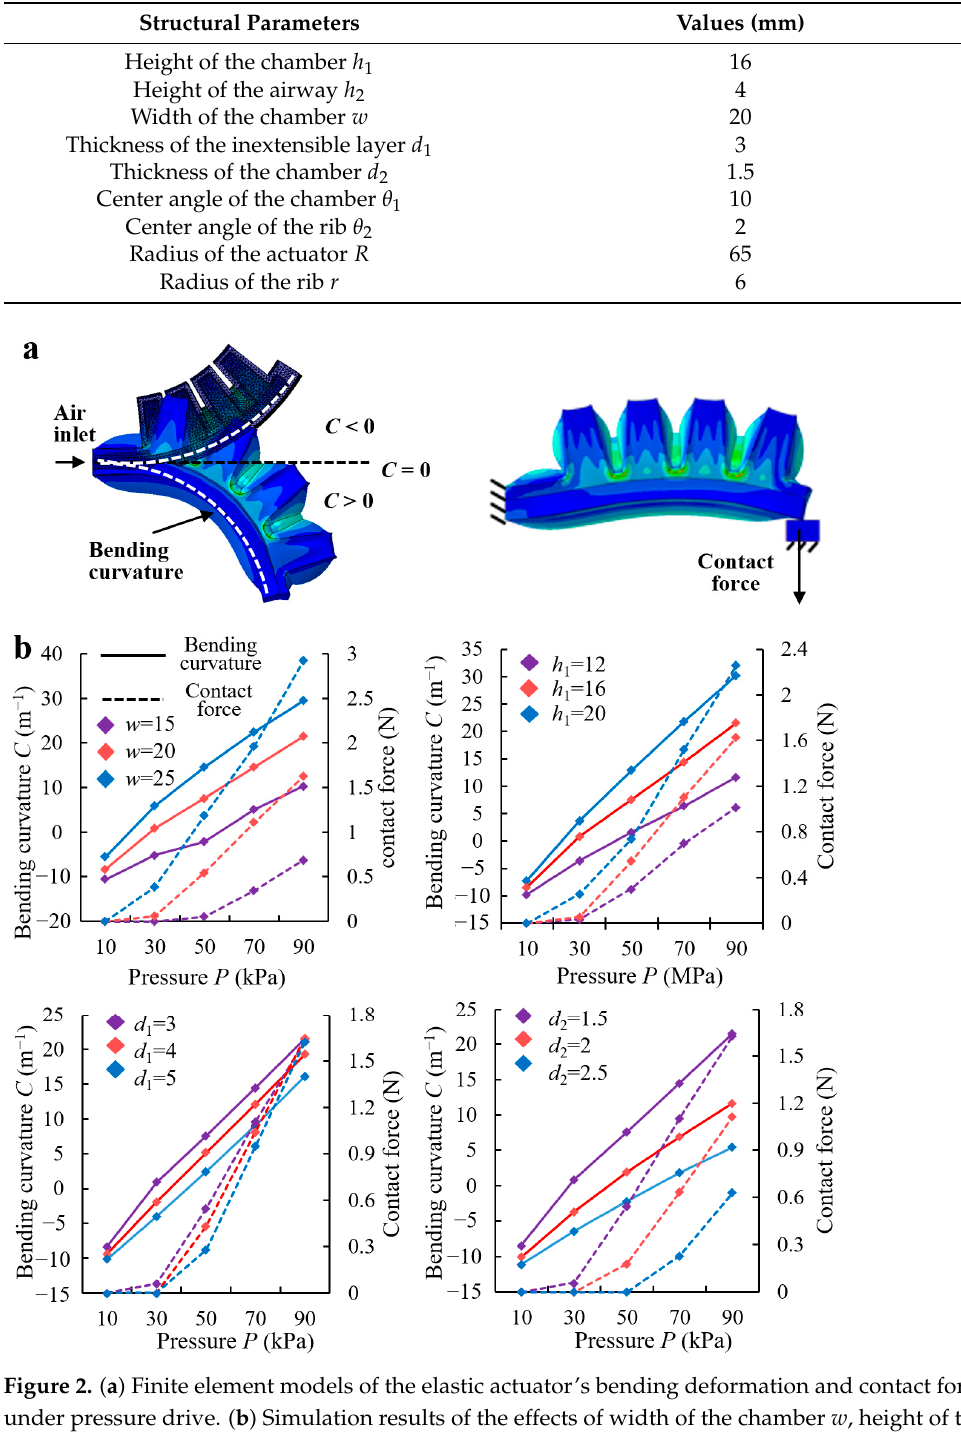
Table 1. Values of structural parameters of the elastic actuator.